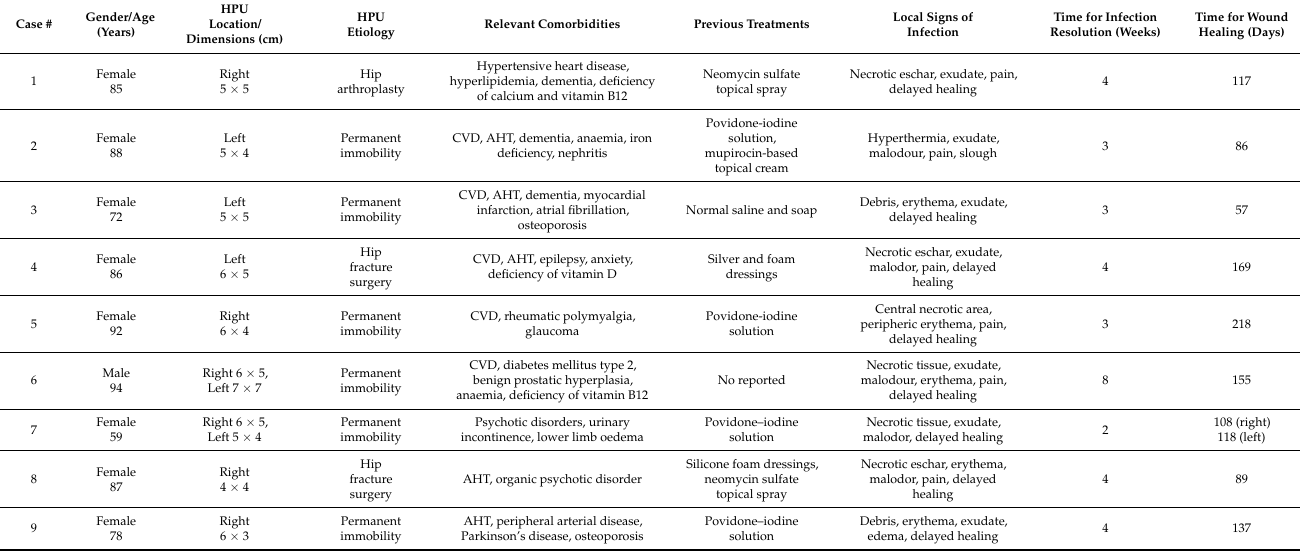
Table 1. Demographic data and wound course overview of the presented